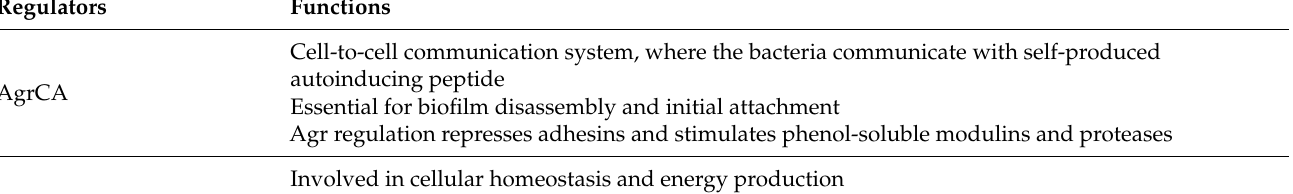
Table 2. Summary of the role of two-component systems and other regulatory genes involved in the virulence genes expression in Staphylococcus aureus [77–83].